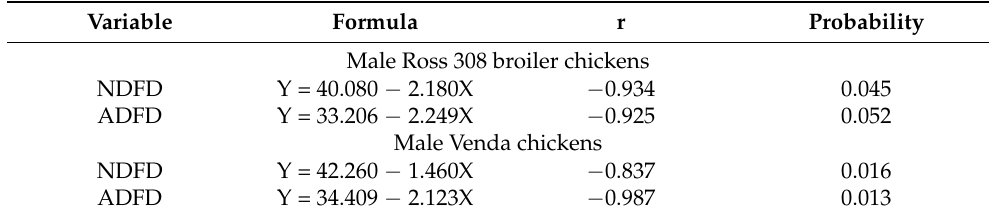
Table 5. The relationships between the dietary crude fiber level (%) and nutrient digestibility (%) of the male Ross 308 broiler and Venda chickens aged 14–21 days.